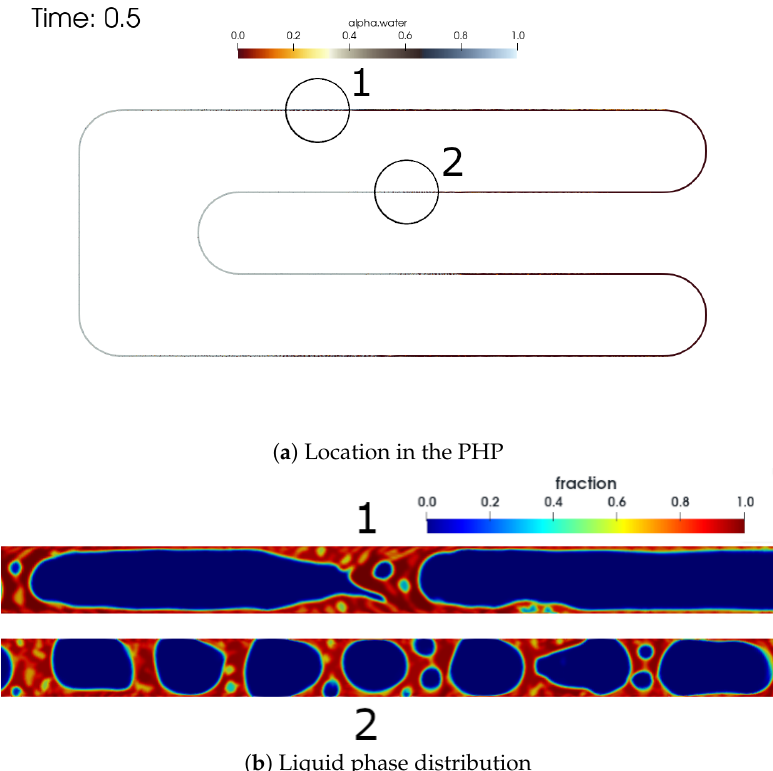
Figure 22. Numerical results of the Xu model [29] in 0.5 s for 100 W input power.